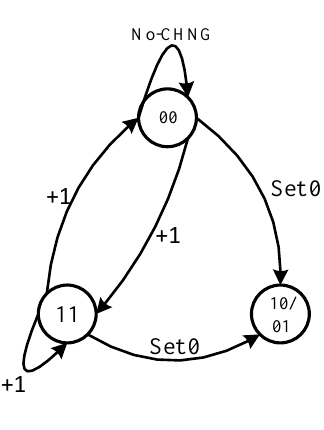
Figure 3. Co-presence state diagram model of ID pairs.